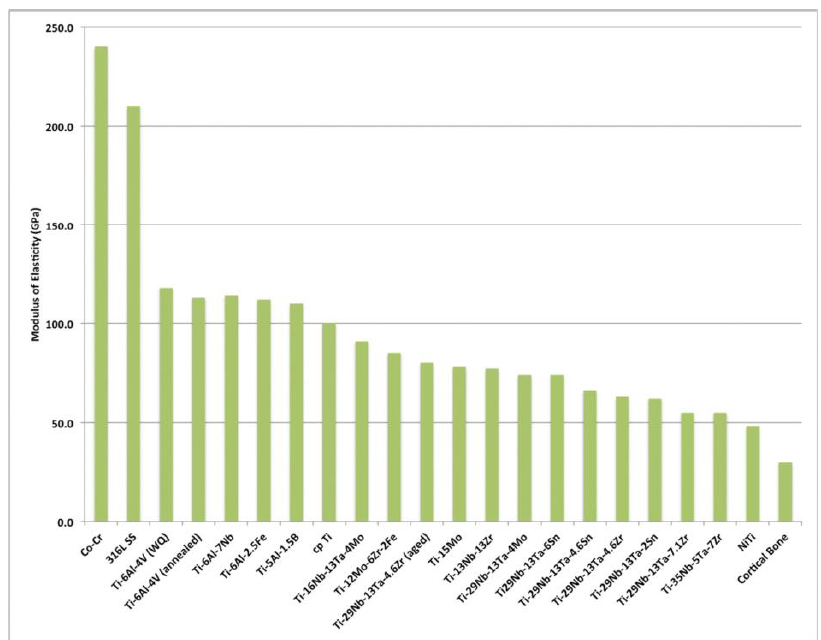
Figure 5. A plot showing the modulus of elasticity, E , (GPa) of commercially important and experimental Ti alloys used in orthopedic implants. The quantity E for Co-Cr, 316L stainless steel, and cortical bone are also shown.